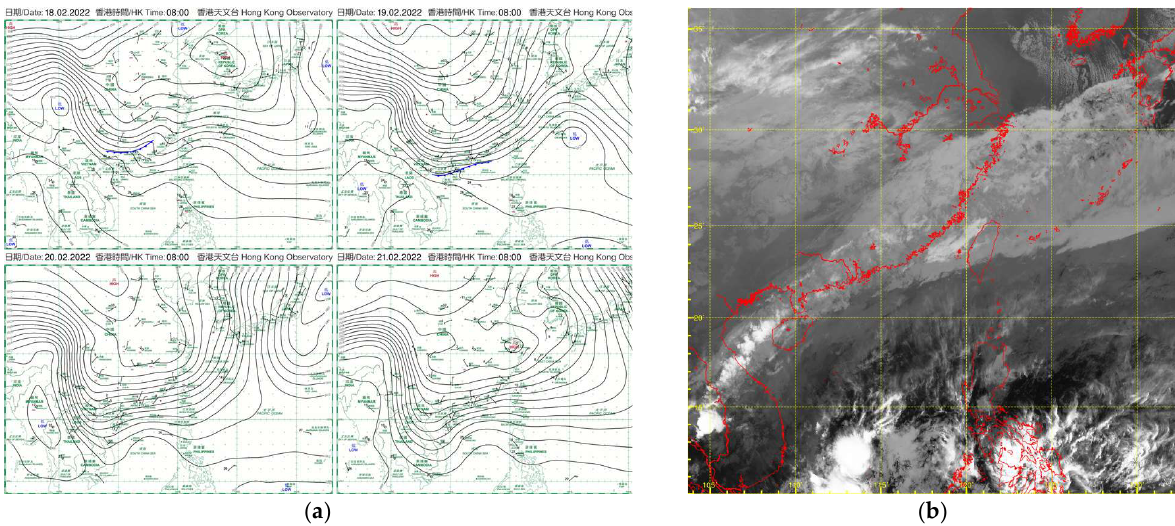
Figure 12. ( a ) Surface analysis charts at 00 UTC of 18–21 February 2022; and ( b ) infrared satellite imagery at 00 UTC on 21 February 2022.